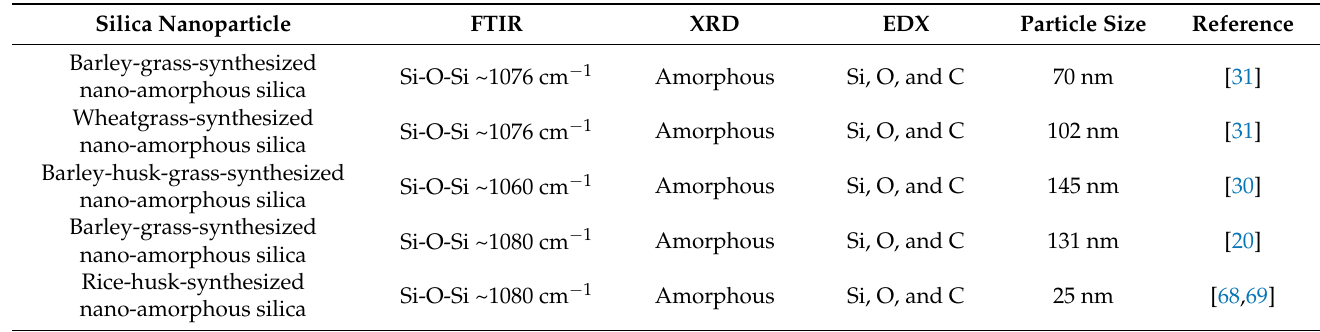
Table 1. Characterization results of nanoparticles from different